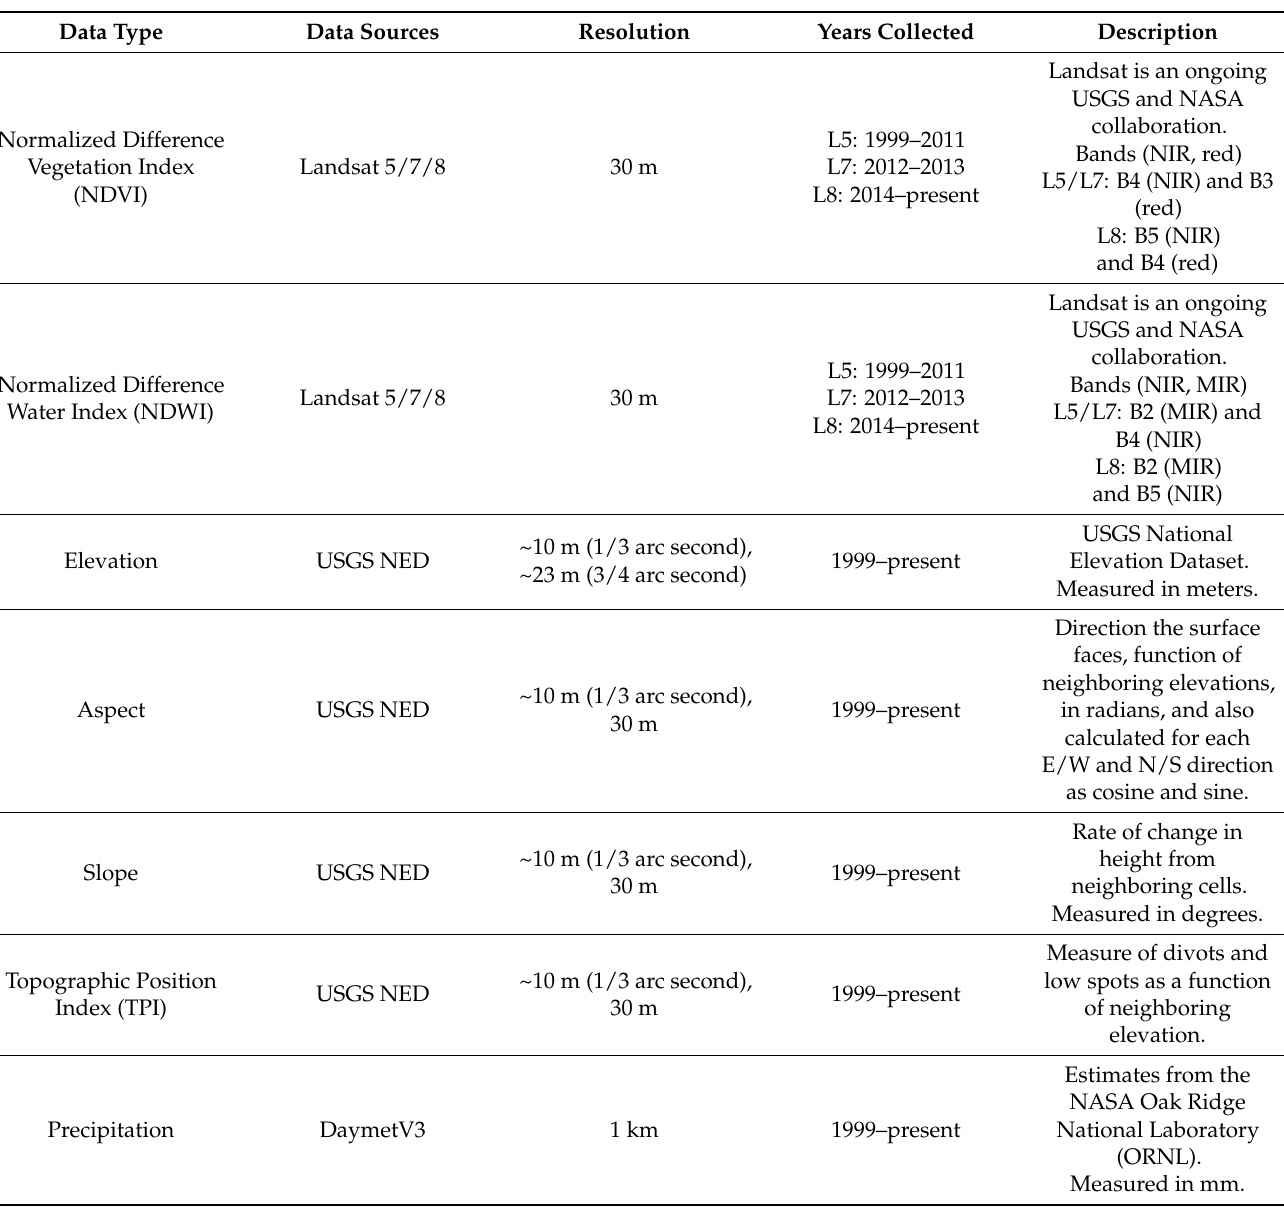
Table 1. Table of covariate data types gathered from Google Earth Engine to create predictive models for crop yield and protein datasets gathered from